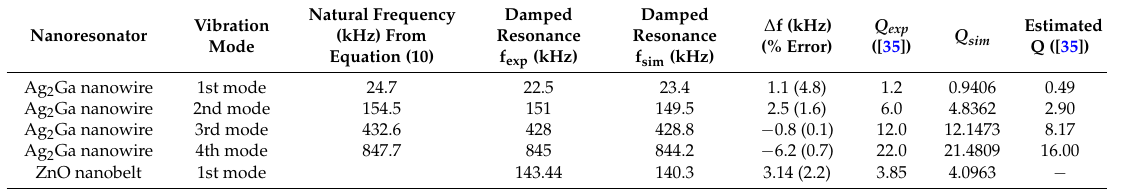
Table 2. Comparing natural frequencies and Q factors of nanoresonators from experiments and simulations.